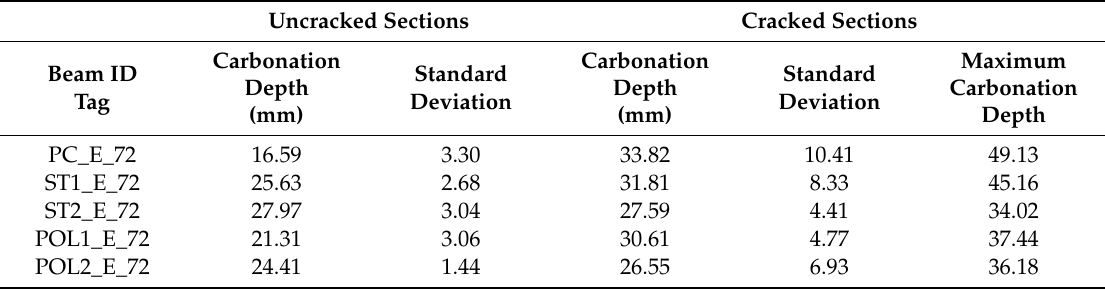
Table 4. Carbonation depths and standard deviation for 72-month exposed